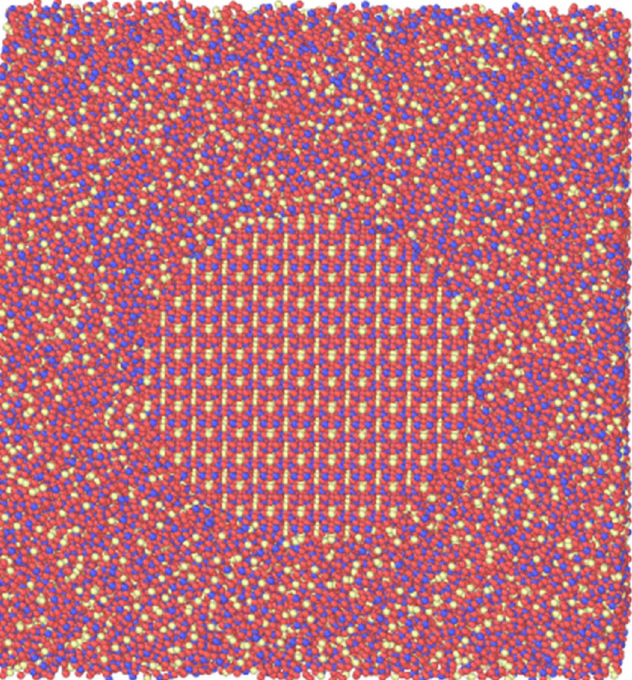
Figure 4. Starting snapshot of the combined crystal and melt of the 1–2 system at T = 1040 K. The radius of this cluster is 41 Å. The silicon, oxygen, and barium atoms are colored red, yellow, and blue, respectively.